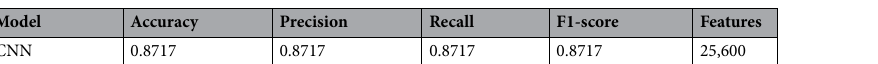
Model Accuracy Precision Recall